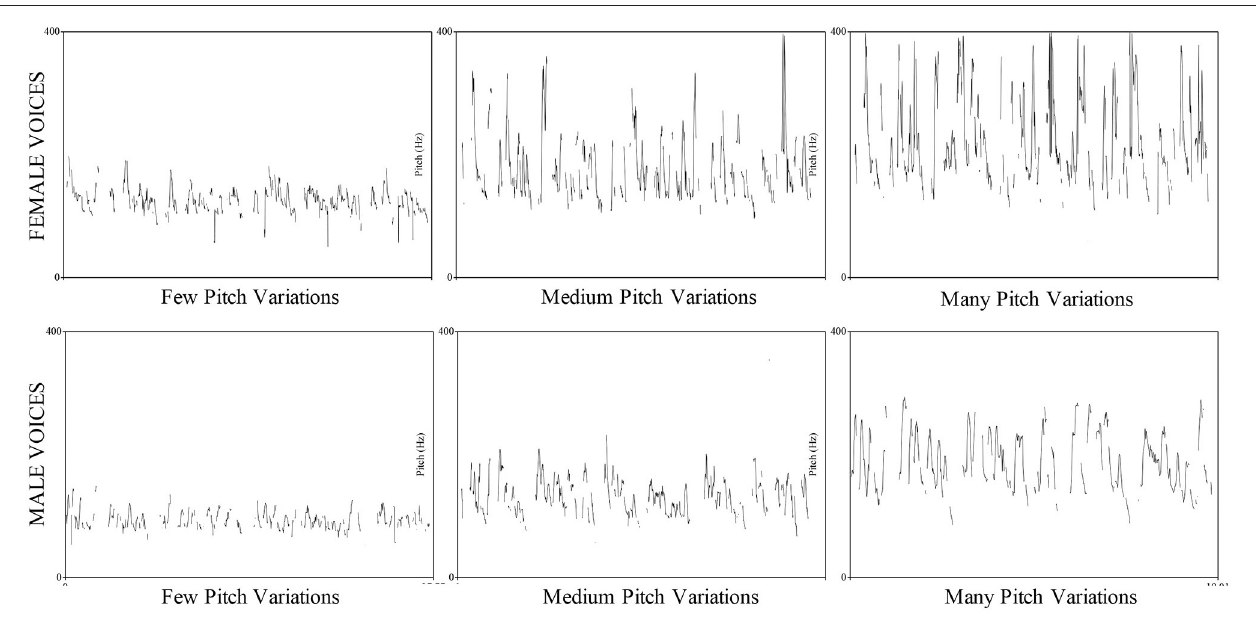
FIGURE 1 | Intonation.